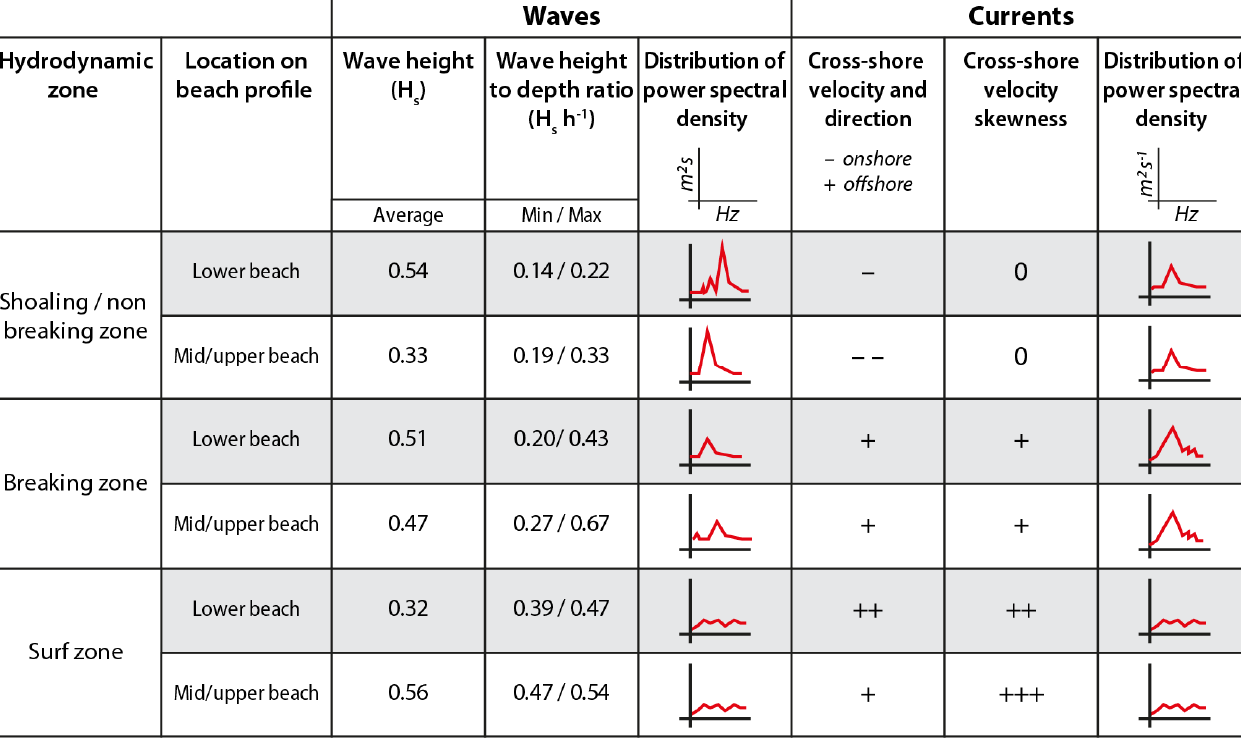
Figure 16. Summary diagram of the main hydrodynamic characteristics observed in each hydrodynamic zone of the investigated beach. The numbers of + and − signs represent the relative intensity of cross-shore currents and